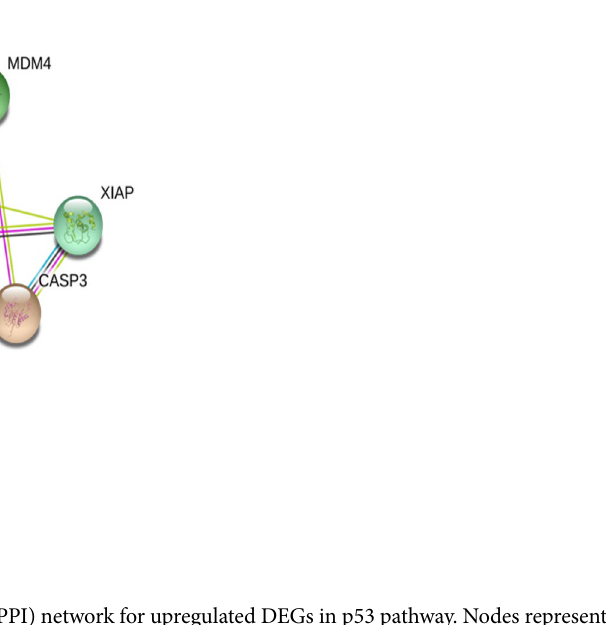
Figure 1. Protein–protein interaction (PPI) network for upregulated DEGs in PI3K/Akt pathway. Nodes represent proteins and lines represent interactions of proteins in networks.